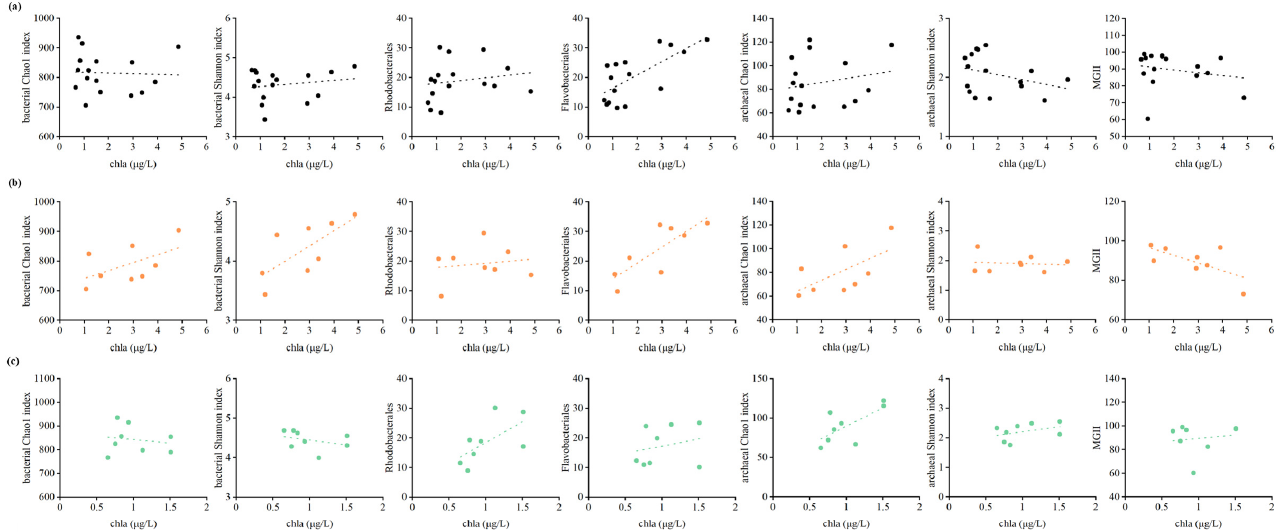
Figure 6. Correlations of Chao1 index, Shannon index, relative abundance of dominant taxa with chl a content during the green tide ( a ), the outbreak ( b ) and decline ( c )